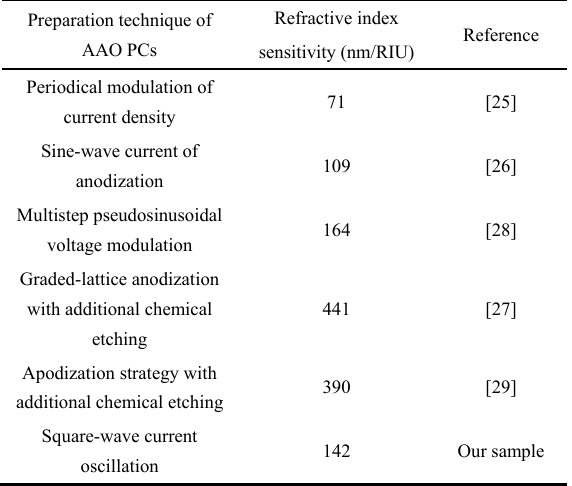
Table 1 Refractive index sensitivities of AAO PCs reported in the